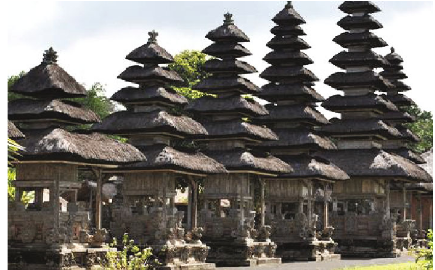
Figure 1: The shape of Meru with high overlapping